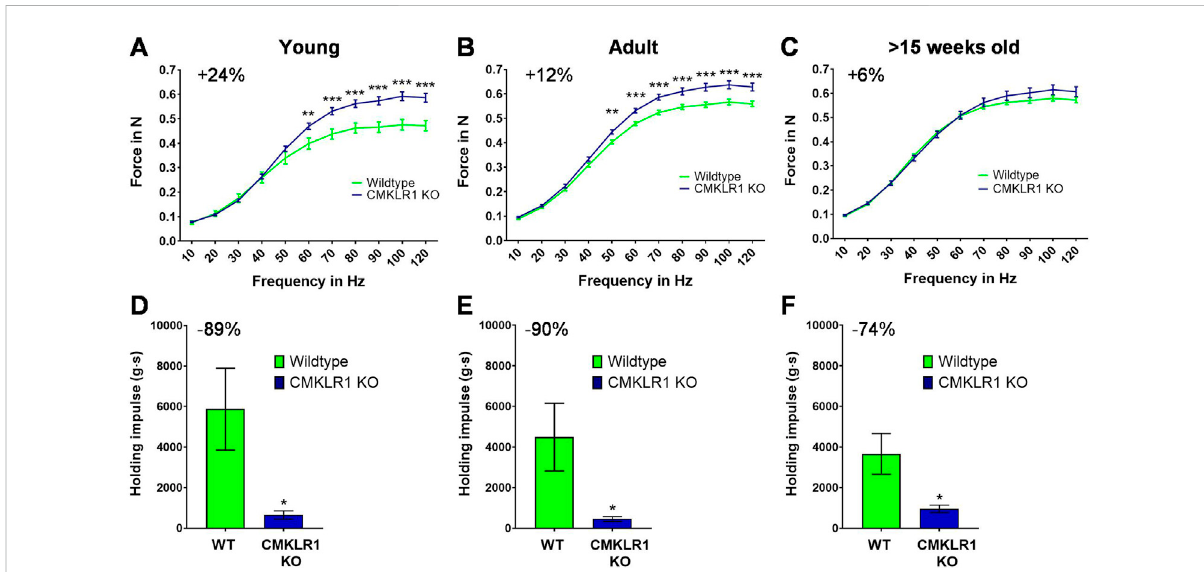
FIGURE 1 Blockade of CMKLR1 increases muscle strength at the expense of strength endurance Isometric muscle strength of the hind limb of young (A) , adult (B) and full grown (C) CMKLR1 knockout and control mice. Values are expressed as means ± SEM; **: p < 0.01, ***: p < 0.001 versus wild-type control mice by unpaired t -test; n = 17 – 21 per group. Vertical inverted grip strength in young (D) , adult (E) and full grown (F) CMKLR1 knockout and control mice. Values are expressed as means ± SEM; *: p < 0.05, versus wild-type control mice by unpaired t -test; n = 10 per